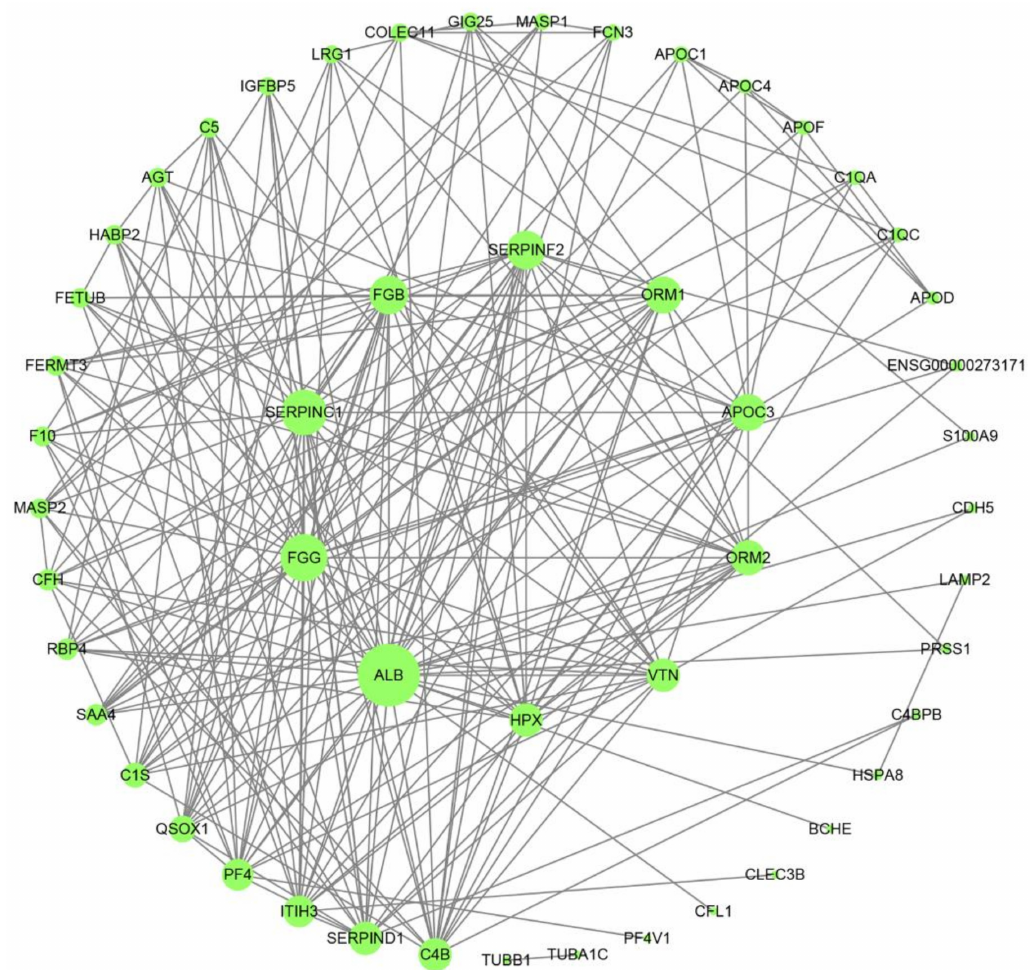
Figure 6. DEPs co-expression network. Nodes are target proteins. The size of the nodes represents the difference in protein expression, and the lines represent the connection degree. The higher the connectivity, the more important it is in the protein-protein interaction (PPI)